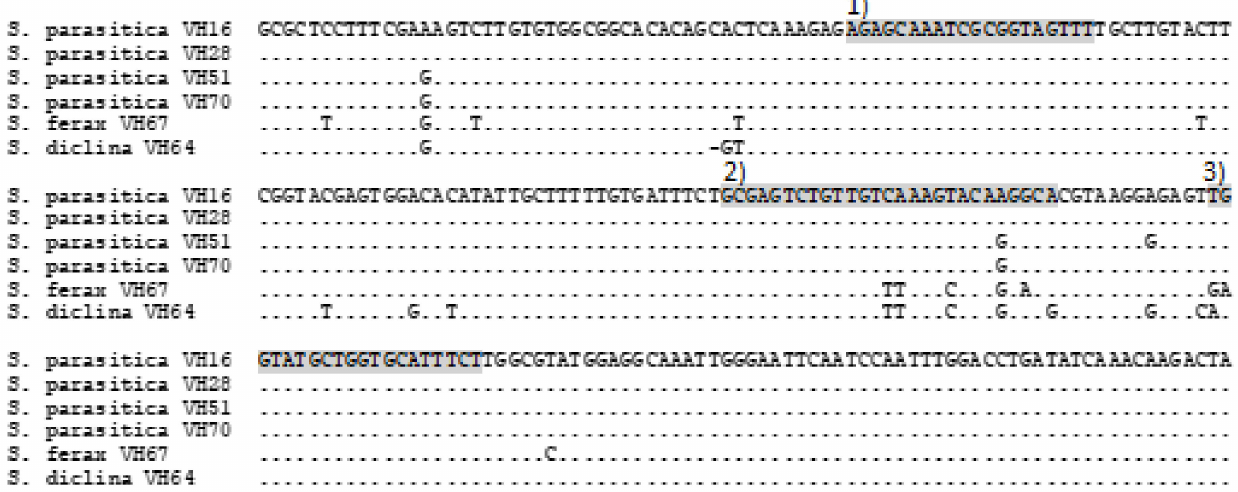
Figure 1. Alignment of the internal transcribed spacer (ITS) region and 28S rRNA gene sequences of oomycetes isolated from salmonid fish, fry and eggs. Shaded in grey are (1) Saprolegnia parasitica primer-F, (2) S. parasitica probe-R and (3) S. parasitica primer-R [11] used in this study for qPCR